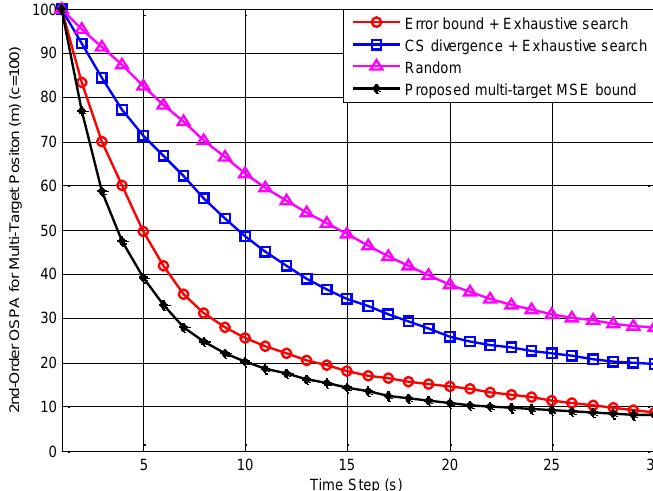
Figure 2. 200 Monte Carlo (MC) run average of optimal sub-pattern assignment (OSPA) error distance and proposed mean-square error (MSE) bound for multi-target position estimates versus time.